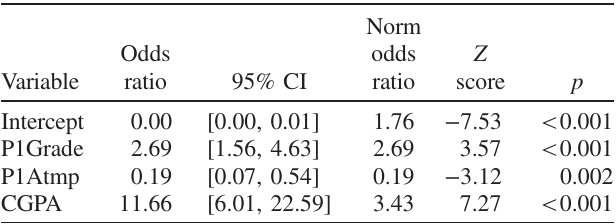
TABLE VIII. Physics 2: Optimal institutional logistic model.